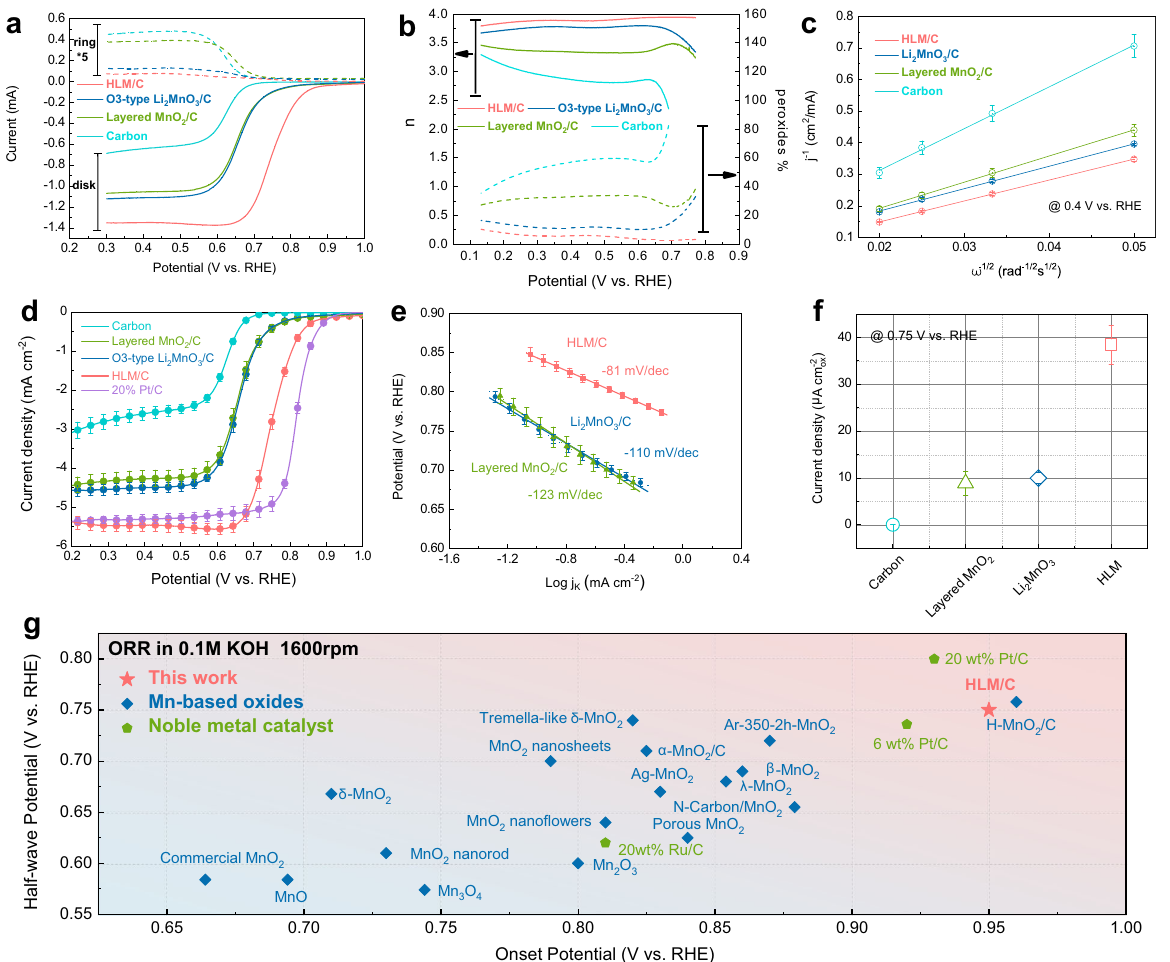
Fig. 3 Electrochemical activity of the obtained samples in 0.1 M KOH aqueous solution. a ORR polarization curves of HLM/C, Li 2 MnO 3 /C, and layered MnO 2 /C and carbon at a rotation rate of 1600 rpm in O 2 -saturated 0.1 M KOH solution. b Electron transfer numbers ( n ) and HO 2 − yields (y) for HLM/C, Li 2 MnO 3 /C, layered MnO 2 /C and carbon. c Koutecky-Levich plots. d Linear sweep voltammetry curves of HLM/C, Li 2 MnO 3 /C, layered MnO 2 /C, carbon, and 20% Pt/C obtained at O 2 -saturated 0.1 M KOH with a scan rate of 5 mV s − 1 . e The Tafel plots of HLM/C, Li 2 MnO 3 /C and layered MnO 2 /C. f Speci fi c activities of HLM/C, Li 2 MnO 3 /C, layered MnO 2 /C and carbon. The current density at 0.75 V vs. RHE normalized by BET surface area is used as a benchmark for the comparison. g Comparison of HLM with other reported Mn-based oxides and noble metal catalysts. Note: (i) The onset potential is the potential at which the current density exceeds 0.1 mA cm -2 , and the half-wave potential is the potential at which the current density is equal to half of the diffusion current density. (ii) The onset potential and half-wave potential were taken from the text or directly read from the graphics. (iii) The mass loading of reported Mn-based oxides ranges from 0.073 mg cm -2 to 0.465 mg cm -2 . (iv) Error bars represent the standard deviation of at least three independent